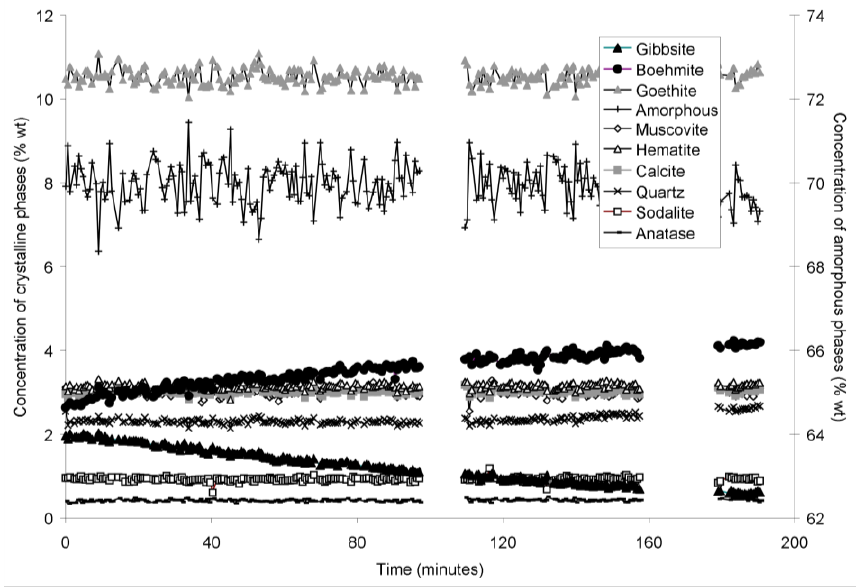
Figure 4. Concentration of crystalline and amorphous phases in bauxite residue slurry in capillary reaction vessels as a function of treatment time at 150 °C, as determined by Rietveld-based quantitative mineral analysis of X-ray diffractograms. Note that amorphous content is plotted on the secondary Y axis and represents contributions from X-ray amorphous minerals in bauxite residue, water in the slurry, and the fused silica capillary. Gaps in data from 100–110, and 160–180 min were caused by beam loss at the synchrotron. Heating of the slurry continued during beam